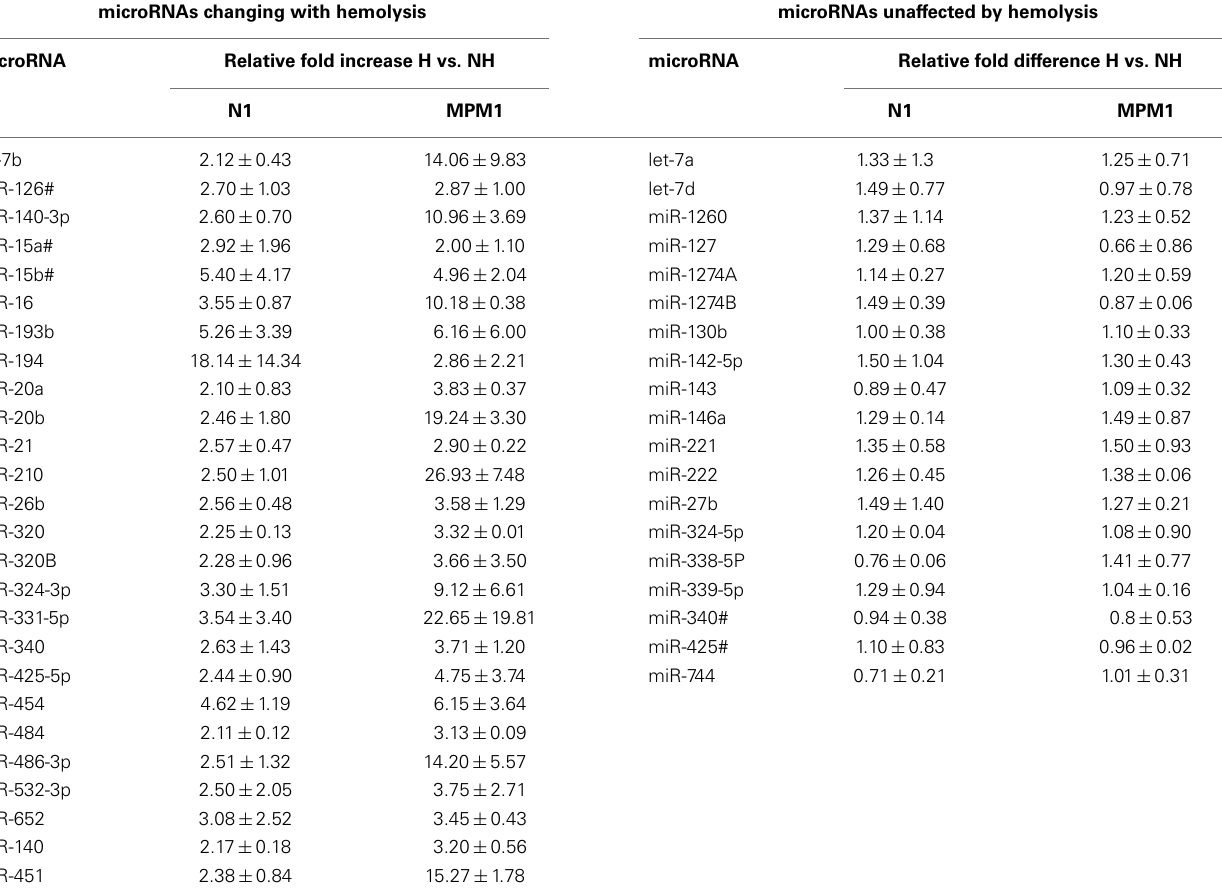
Table 5 | Subsets of biomarker-endogenous control